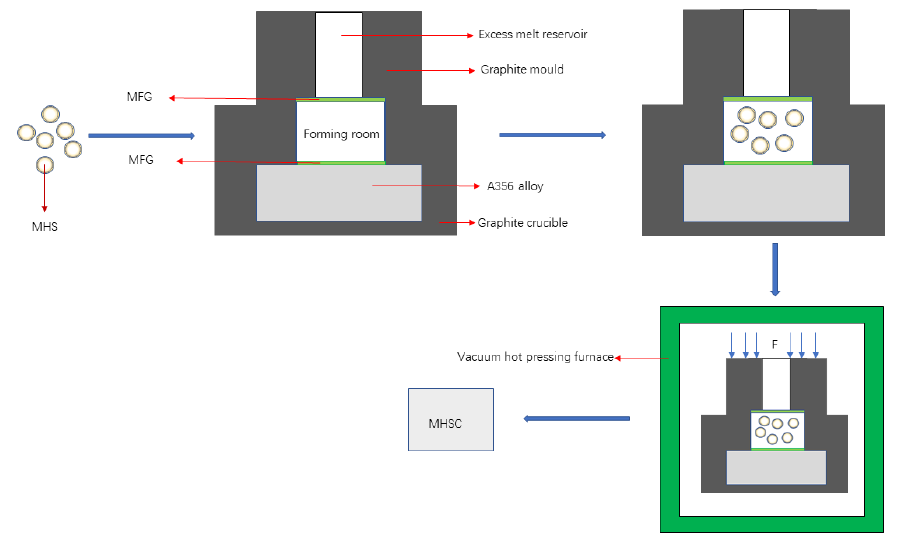
Figure 3. The schematic of the metal hollow sphere composite (MHSC) fabrication process.